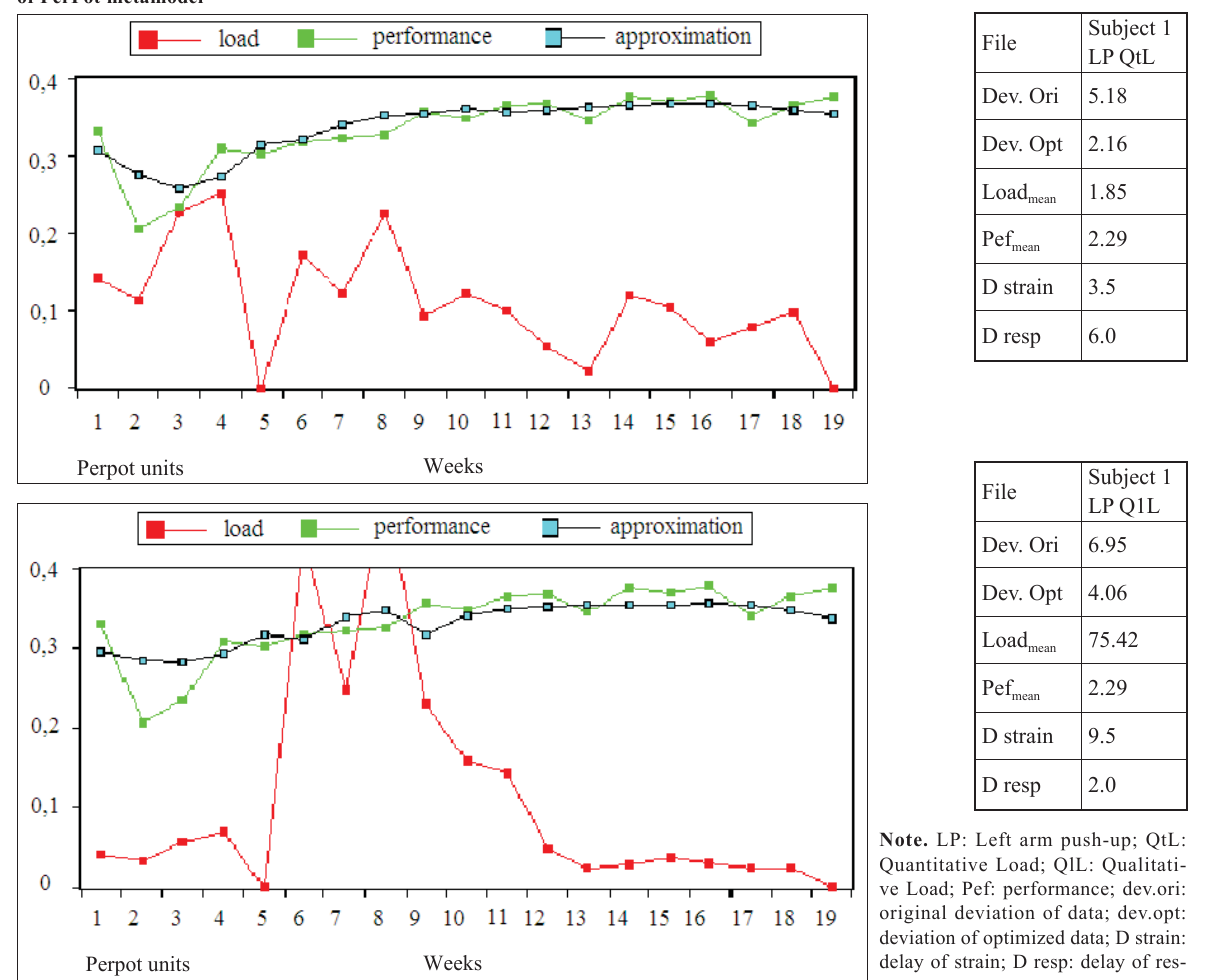
Fig. 5. Quantitative (upper graphs) and qualitative (lower graphs) load with performance of left arm push-up interaction by means of PerPot